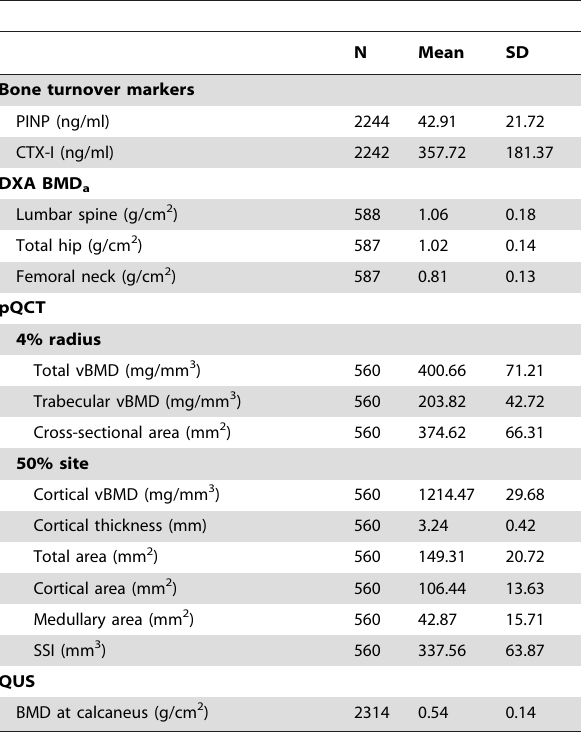
Table 1. Mean (SD) of bone turnover markers, DXA, pQCT and QUS